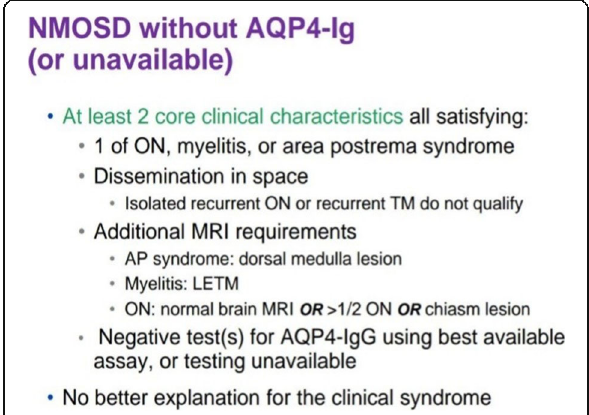
Fig. 2 International consensus diagnostic criteria for seronegative neuromyelitis óptica spectrum disorders [16]. NMOSD neuromyelitis spectrum disorders, AQP4-IgG aquapurine-4 immunoglobulin G, ON